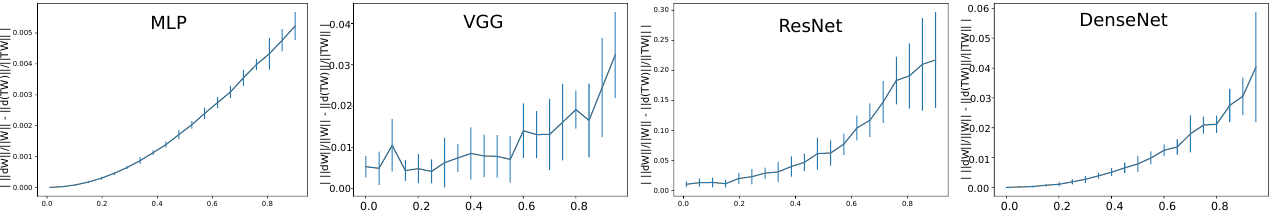
Figure 5. Mean absolute difference ( std-dev) between the back-propagated gradients’ magnitudes of ± teleported networks and their original non-teleported network. Larger CoB generate larger gradients. Results are for CIFAR-10. Plots for these same models on CIFAR-100 can be found in Appendix